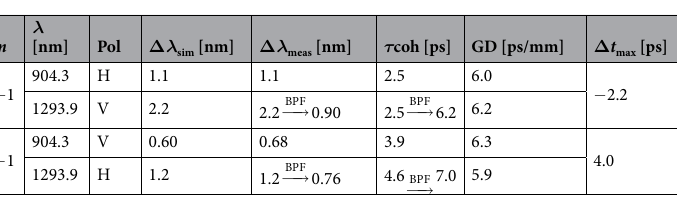
Table 1. Centre wavelength λ , polarisation, spectral bandwidth Δ λ (numerically simulated and measured), coherence time τ coh and group delay GD for each photon of the two pairs. The bandpass-filtering (BPF) is required to match the longwave photons’ bandwidths for the sake of spectral indistinguishability. Δ t max represents the maximal time delay between photons of one generated pair, obtained by comparing their total group delays in a 10 mm crystal. One can see that in one SPDC process the shortwave photon can leave the crystal up to 2 ps earlier whereas in the other one the shortwave photon may be delayed by up to 4 ps with respect to the longwave one. The measured discrepancy in the filtered bandwidths (0.90 vs. 0.76 nm) stems from the resolution limit of our spectrometer (0.1 nm).